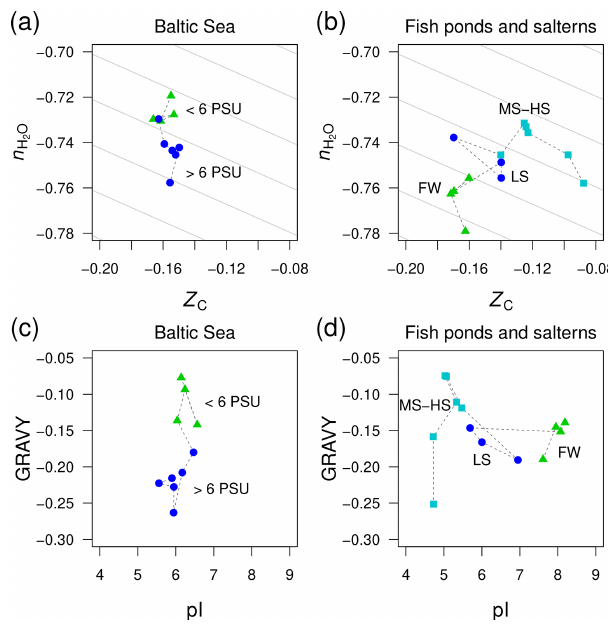
Figure 6. Divergent trends of n H and Z C of proteins from 2 O metagenomes for (a) the Baltic Sea and (b) freshwater and higher- salinity samples from southern California (Rodriguez-Brito et al., 2010). The datasets from Rodriguez-Brito et al. (2010) are classi- fied according to salinity: freshwater (FW; three samples at differ- ent times from the tilapia channel and one sample from the prebead pond), low salinity (LS; three samples at different times from the low salinity saltern), and hypersaline (MS–HS; four samples from a medium salinity and two from a high salinity saltern). Plots (c) and (d) show GRAVY and pI computed for the same datasets. Back- ground guidelines have slopes equal to that of the n H – Z C linear 2 O regression for amino acids in Fig.